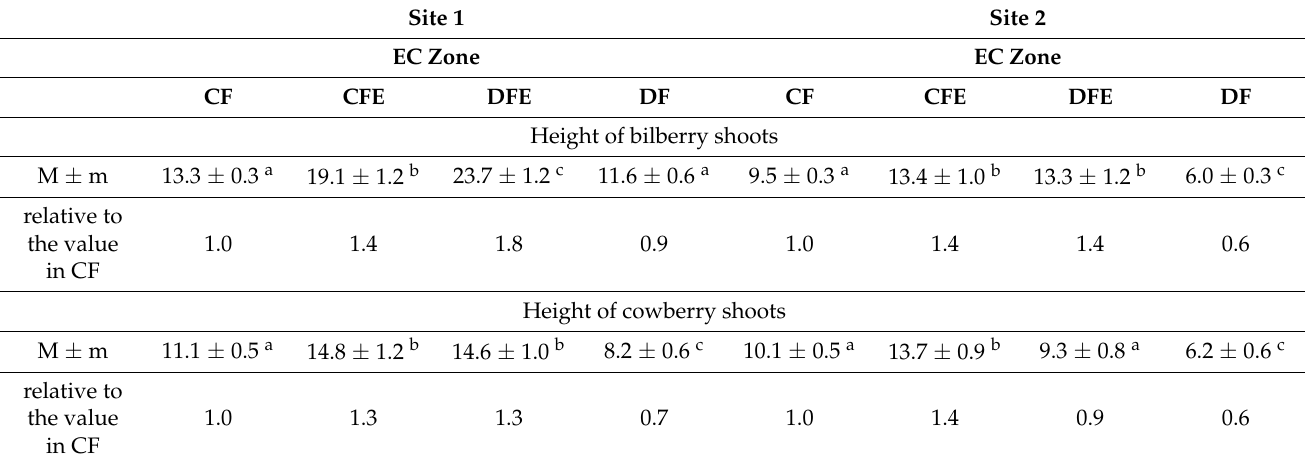
Table 4. Mean percentage cover and shoot height values for bilberry and cowberry in the ecotone complex.